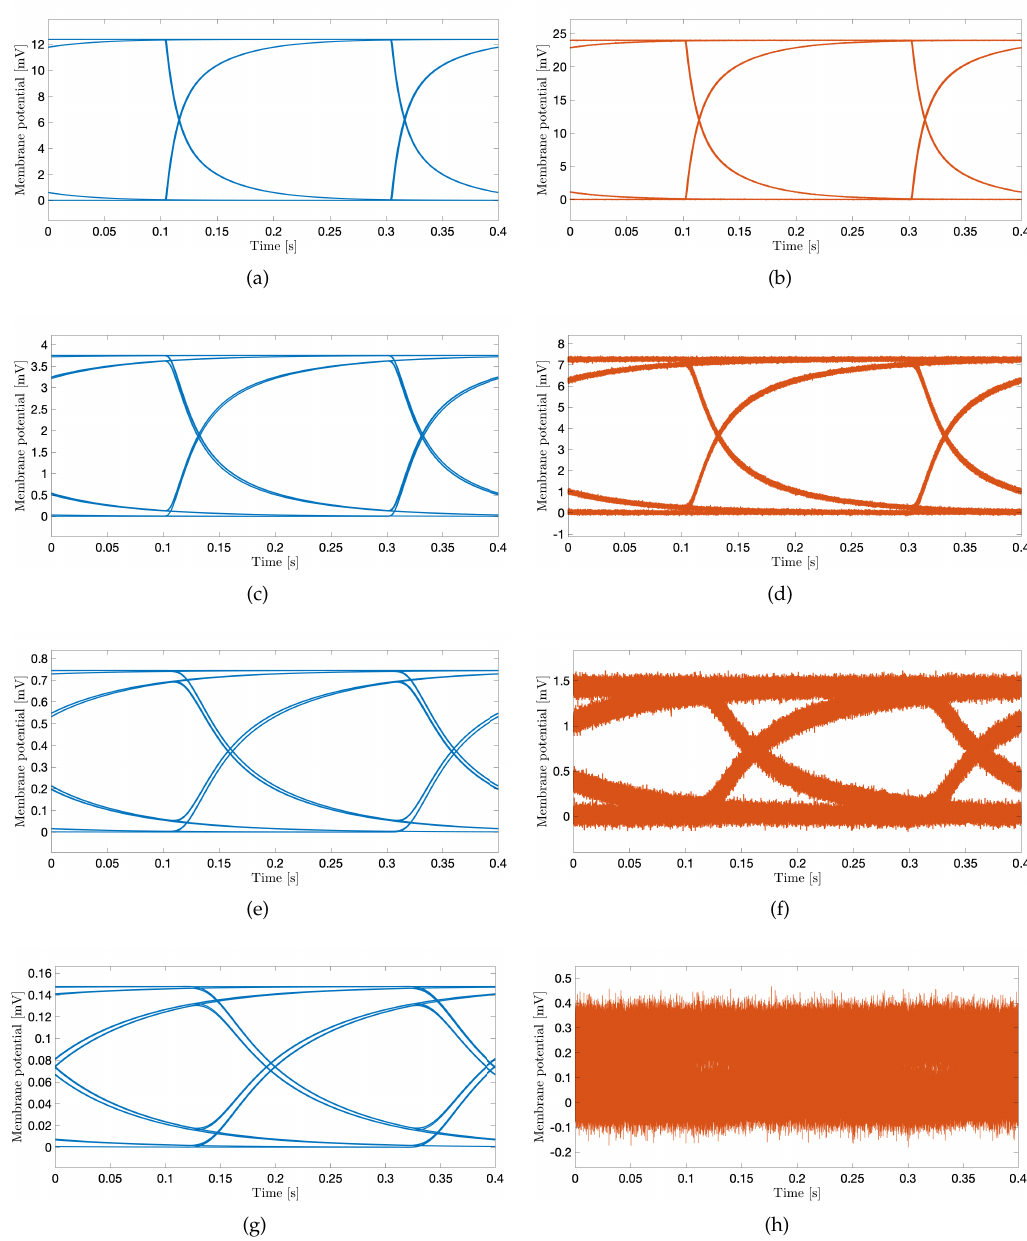
Figure 7. The eye diagram of subthreshold cardiac communication system. The stimulation amplitude is 3 nA, and the transmission rate is 5 bit/s. Blue curves correspond to noiseless scenarios; orange curves correspond to noisy scenarios. ( a , b ): The transmission distance corresponds to the one-cell length. ( c , d ): The transmission distance corresponds to the four-cell length. ( e , f ): The transmission distance corresponds to the eight-cell length. ( g , h ): The transmission distance corresponds to the twelve-cell